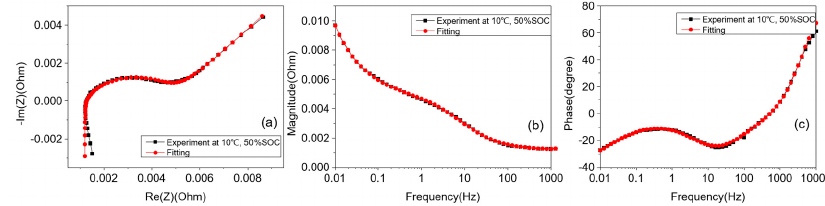
Figure 15. Fitting result: ( a ) EIS; ( b ) impedance magnitude; ( c ) impedance phase.